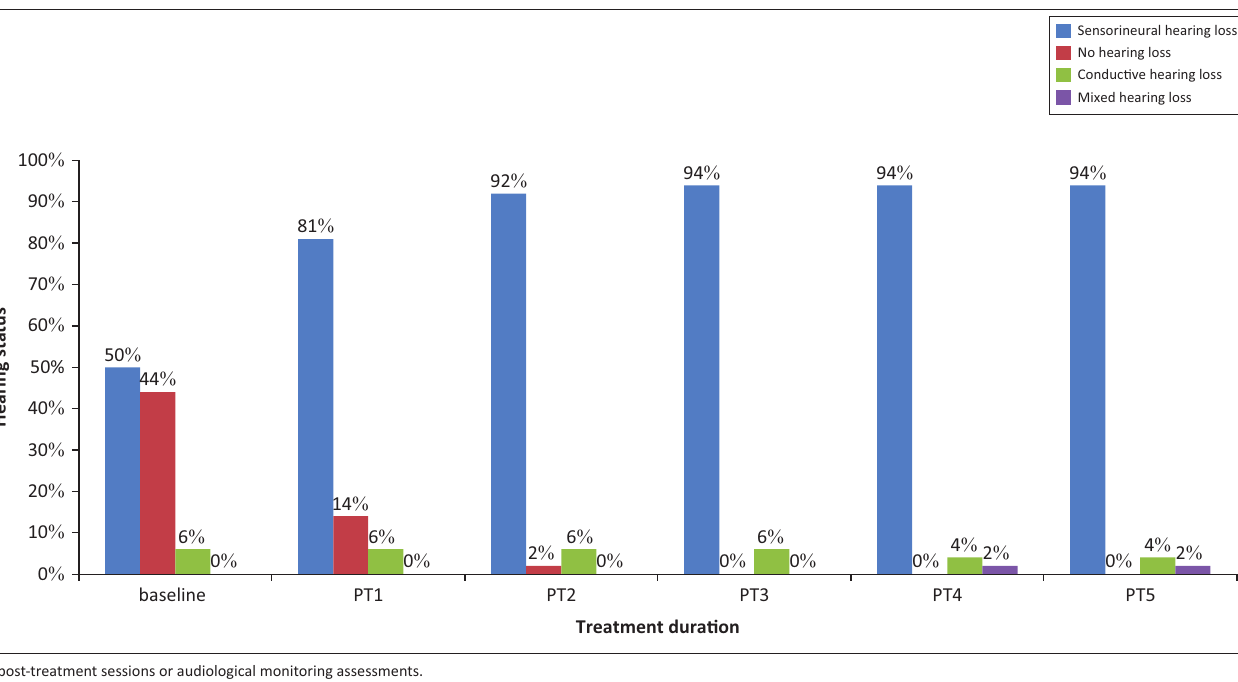
FIGURE 8: Type of hearing loss over treatment duration (right